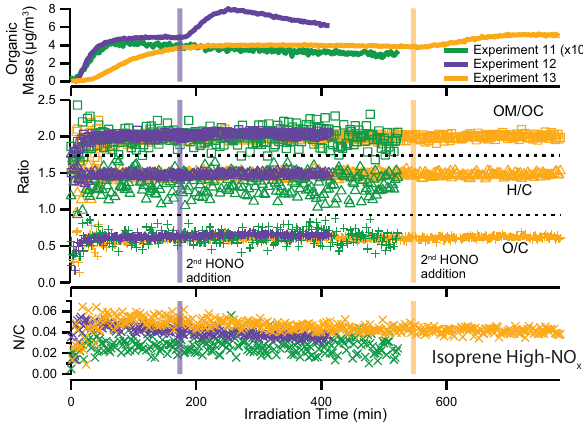
Fig. 6. AMS organic mass (not corrected for collection efficiency), elemental ratios, and OM/OC for isoprene high-NO x experiments. Experiment 11 is in green, 12 in purple, and 13 in orange. Dotted lines are provided to visually separate different ratios.